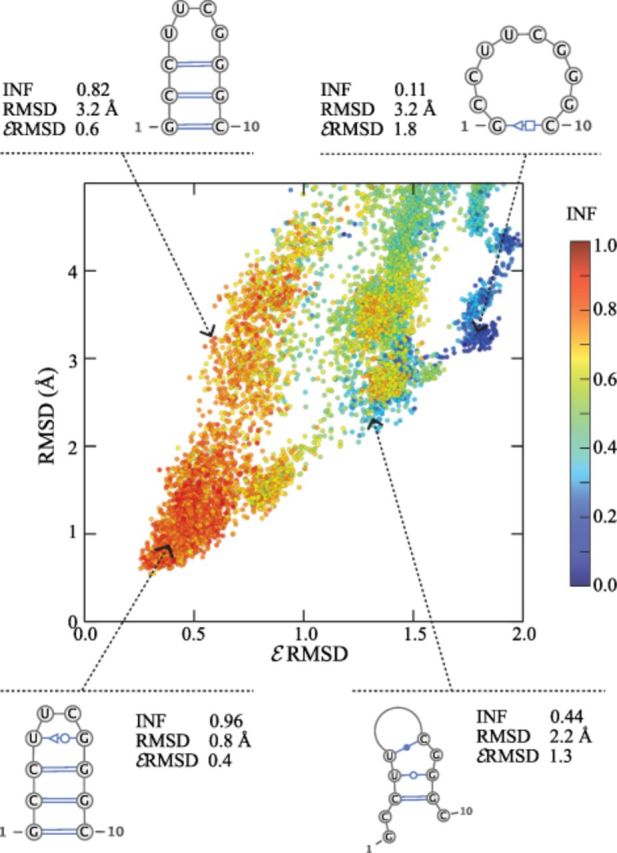
Heavy-atom RMSD from native versus \documentclass[12pt]{minimal}
\usepackage{amsmath}
\usepackage{wasysym}
\usepackage{amsfonts}
\usepackage{amssymb}
\usepackage{amsbsy}
\usepackage{upgreek}
\usepackage{mathrsfs}
\setlength{\oddsidemargin}{-69pt}
\begin{document}
}{}$\mathcal {E}$\end{document}RMSD of snapshots taken from an atomistic molecular dynamics simulation. The difference in the secondary structure between the native state and samples is calculated using the INF measure, which ranges from 1 (identical secondary structure) to 0 (completely different). Very different secondary structures can be found below 4 Å RMSD. Four selected structures with different values of RMSD, \documentclass[12pt]{minimal}
\usepackage{amsmath}
\usepackage{wasysym}
\usepackage{amsfonts}
\usepackage{amssymb}
\usepackage{amsbsy}
\usepackage{upgreek}
\usepackage{mathrsfs}
\setlength{\oddsidemargin}{-69pt}
\begin{document}
}{}$\mathcal {E}$\end{document}RMSD and INF are shown, together with their secondary structure. Figures were generated with Varna (48).